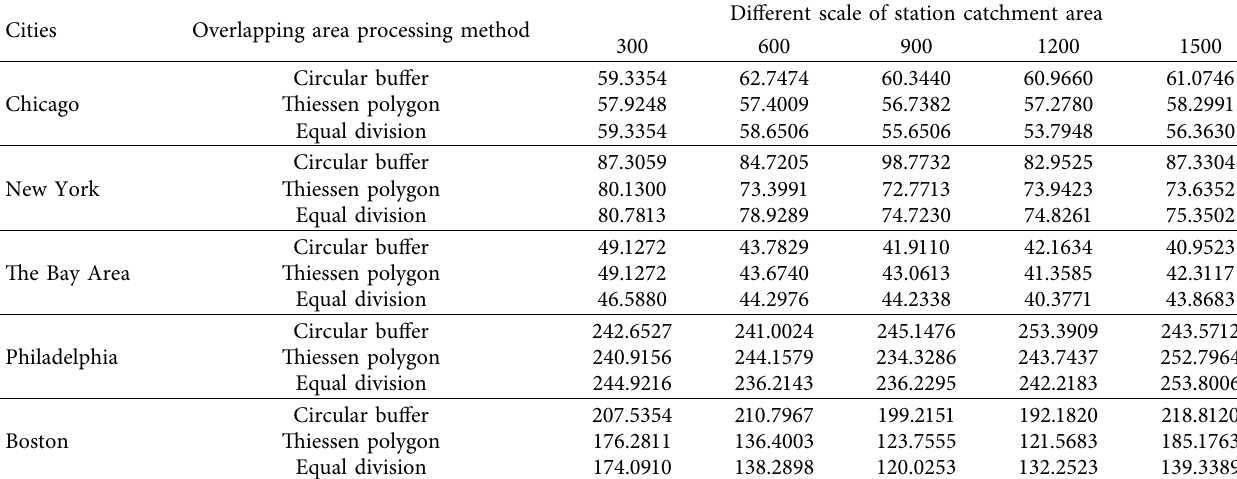
Table 8: Table of the MAPE of linear regression model in five cities.